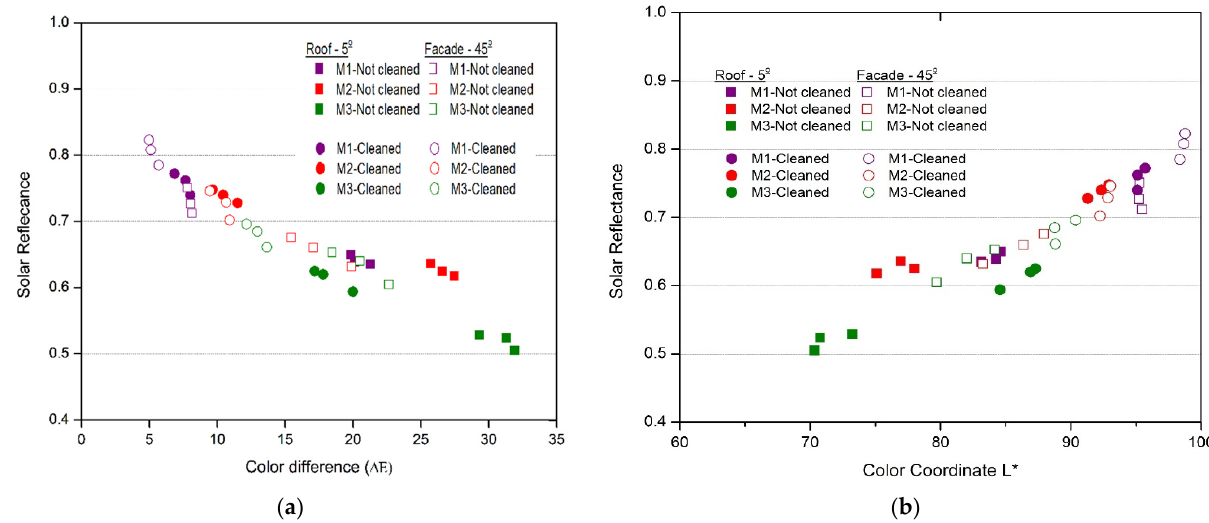
Figure 13. Solar reflectance plotted against ( a ) color difference ( Δ E) and ( b ) coordinate L ∗ . Further, washing the samples after three years of exposure significantly decreased the color difference with respect to unexposed original samples. The color difference of washed samples ranged between 6.8 and 20 for low slope exposed samples, while the values ranged between 5 and 13.6 for high slope exposed samples. The decrease in the L ∗ co-ordinate (White = 100 and black = 0) follows an opposite pattern, compared to the color difference. The decrease of L ∗ was directly proportional to the reflectance decrease, indicating darkening of the surface due to contamination reduced the reflectance (Figure 13b). Coordinate a ∗ , shows a tendency from green (negative) to red (positive).